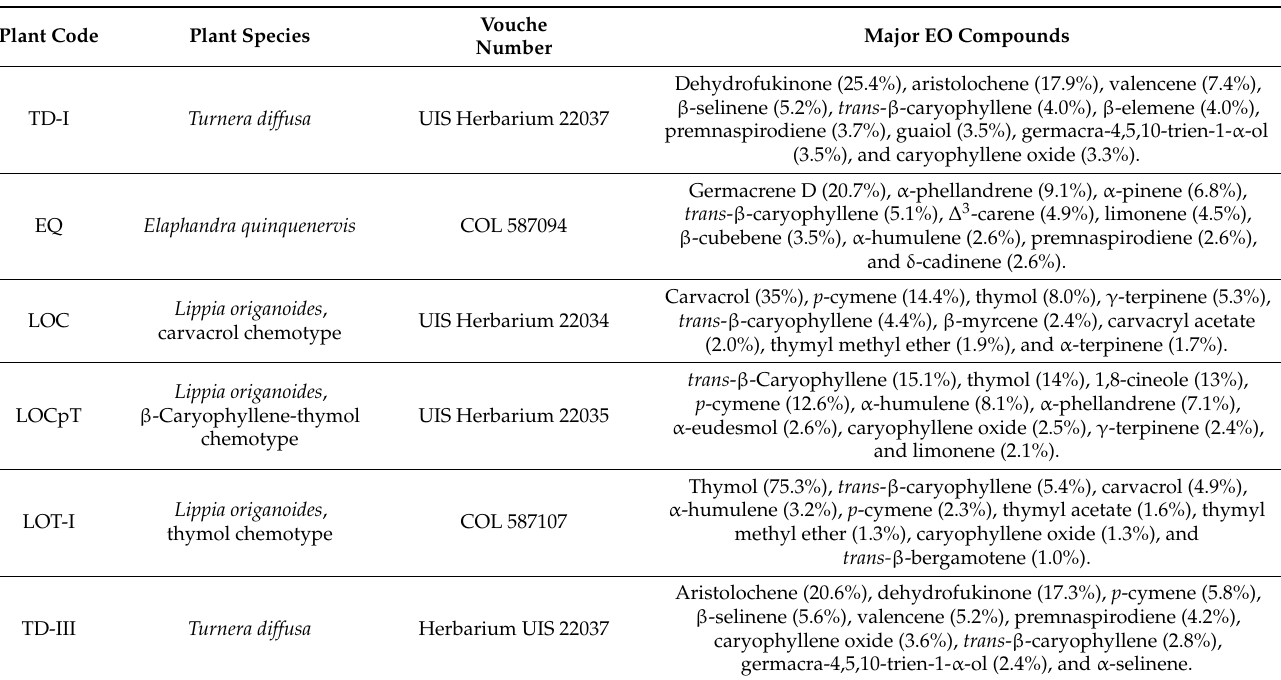
Table 1. Information on the plants and chemical composition of EOs with biological activity (antifun- gal or antibiofilm) against at least one of the Candida